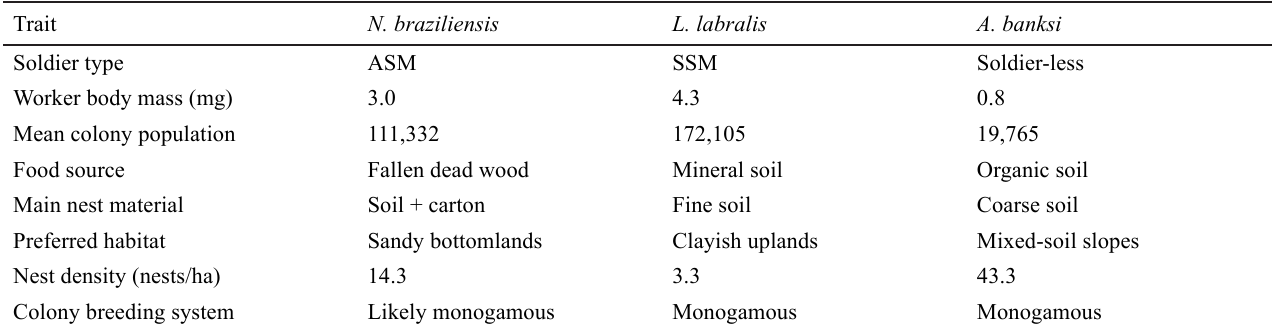
Table 1 . Summary of known life history and ecological traits of the Amazonian termite species Neocapritermes braziliensis , Labiotermes labralis and Anoplotermes banksi . Data from Dupont et al. (2009), Pequeno et al. (2013, 2015), Bourguignon et al. (2016), and the current study. For species pictures, see Pequeno et al.